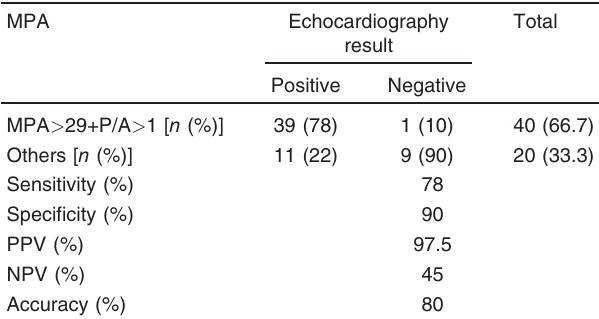
Table 12 Evaluation of different parameters: sensitivity, specificity, positive predictive value, and negative predictive value for main pulmonary artery more than 29+P/A more than